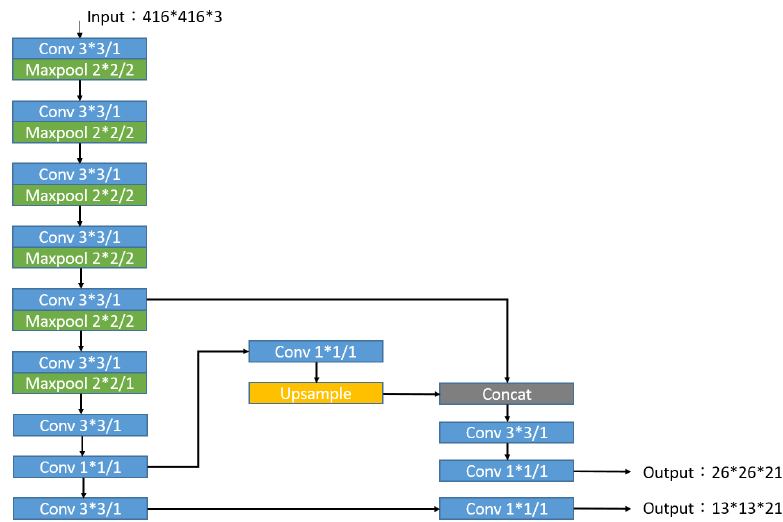
Figure 11. Tiny-YOLOv3 network architecture.